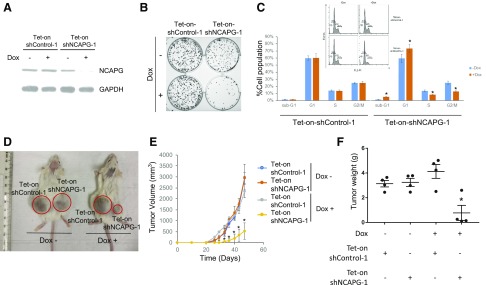
Conditional knockdown of NCAPG inhibits tumor growth in vivo. A) Western blot analysis showing the specific dox-mediated knockdown of NCAPG in cells with tetracycline-inducible shRNA against NCAPG. B) Colony formation assay showing dox-induced NCAPG knockdown cells formed significantly fewer colonies. C) Cell cycle analysis using propidium iodide staining and FACS showing a significantly reduced cell population in S and G2/M phase and a correspondingly higher cell population in G1 and sub-G1 phase in dox-induced NCAPG knockdown cells compared with control cells. D) Representative mouse xenograft imaging showing dox-induced NCAPG knockdown cells formed significantly smaller tumors. E) Tumor volume of mouse xenograft tumor formed by cells containing tetracycline-inducible shRNA against NCAPG or control with or without dox treatment, over time. F) Boxplot of final tumor weight of xenograft tumors shown in E. *P < 0.05.